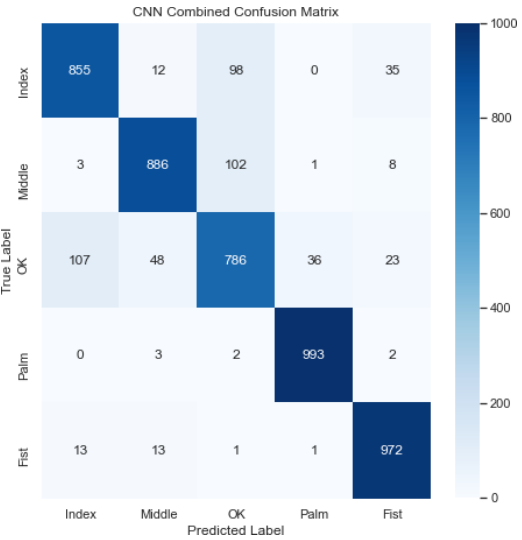
Figure 11. Combined confusion matrix for CNN model. Rows represent actual classes; columns represent predicted classes. Dark blue shading indicates a large value; light blue shading indicates a small value. The average accuracy, precision, recall, and F 1 score for this model were 95.94%, 89.75%, 89.84%, and 89.77%, respectively.